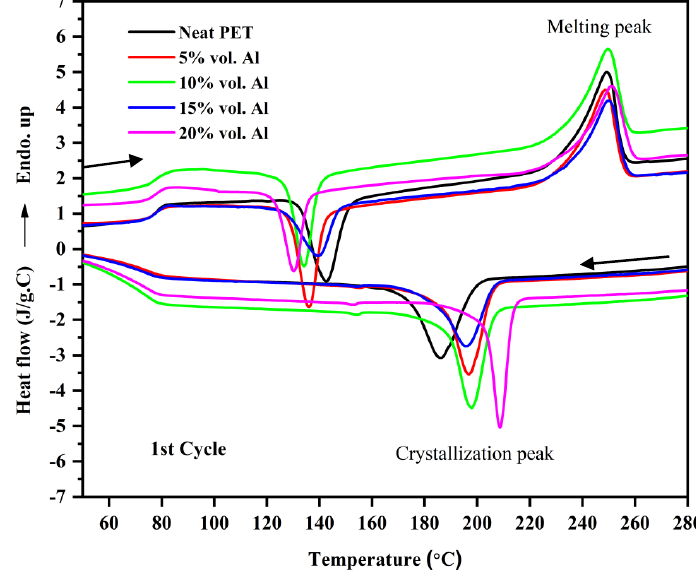
Figure 8. Thermograms of the first DSC heating-cooling cycle of amorphous PET and micro-Al 1/amorphous PET composites. The top curves show heating to the melt; the bottom shows cooling curves from the melt. Table 4. Thermal parameters obtained from the first cycle of DSC thermographs of neat amorphous PET and micro Al 1/amorphous PET composites (Figure 8). T g is the glass transition; T m is the melting peak temperature; T cc is cold crystallisation peak temperature from the amorphous state and T c is peak temperature for crystallisation from the melt.